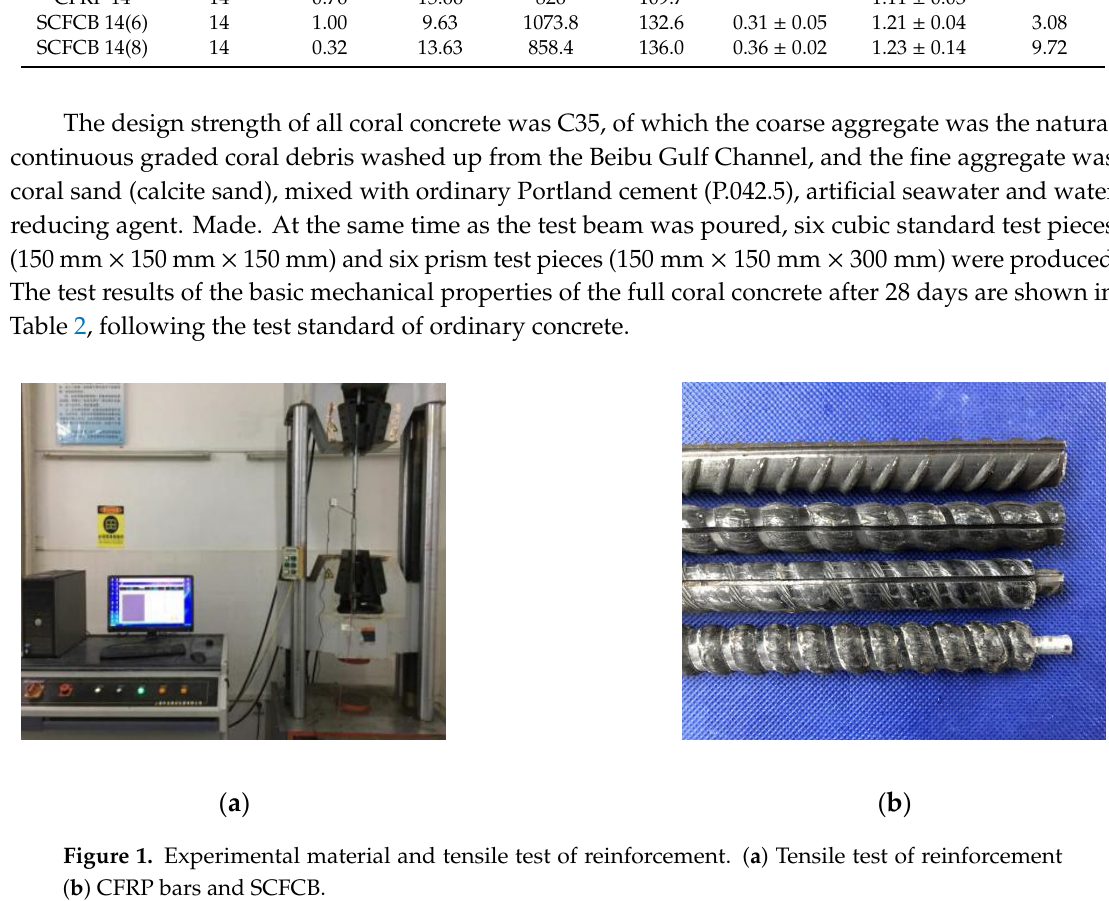
Table 1. Properties of bars.